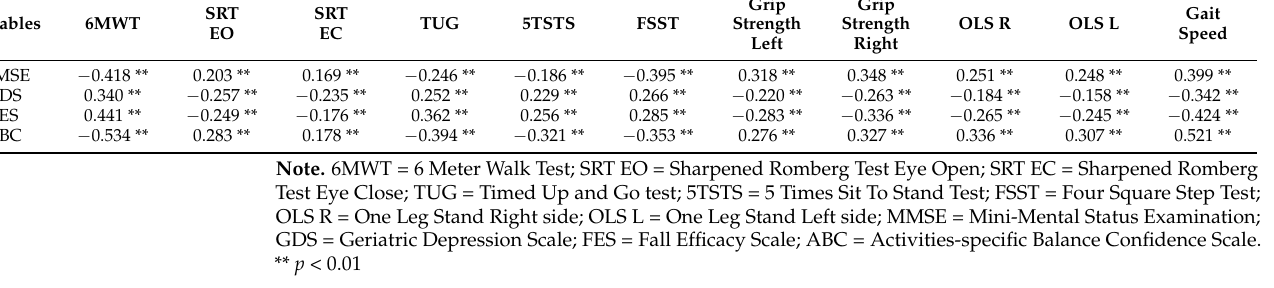
Table 3. Association between Fall Risk Factors and Cognitive Factors ( n = 393).